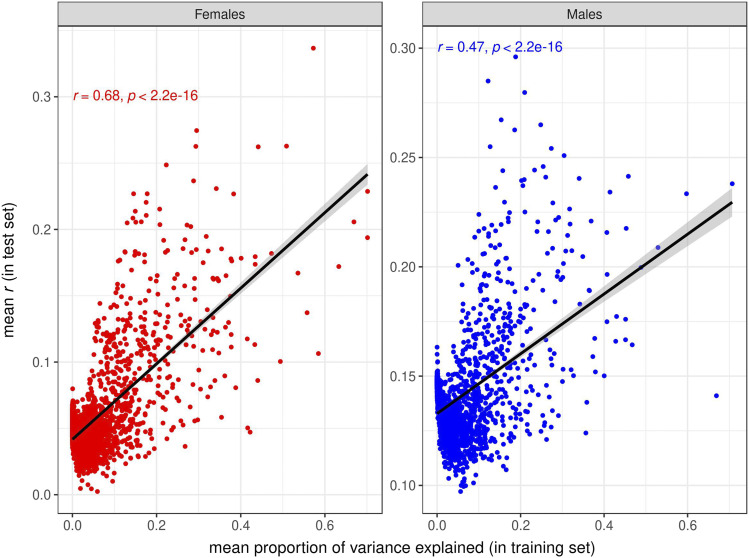
Relationship between prediction accuracy obtained by the GO-GBLUP model, measured as mean r in the test set (on the y-axis), and mean proportion of variance explained by the GO terms in the training set (on the x-axis), for starvation resistance. Each point represents a specific GO term. The black line represents the linear regression fit. The left panel represents females, and the right panel represents males.